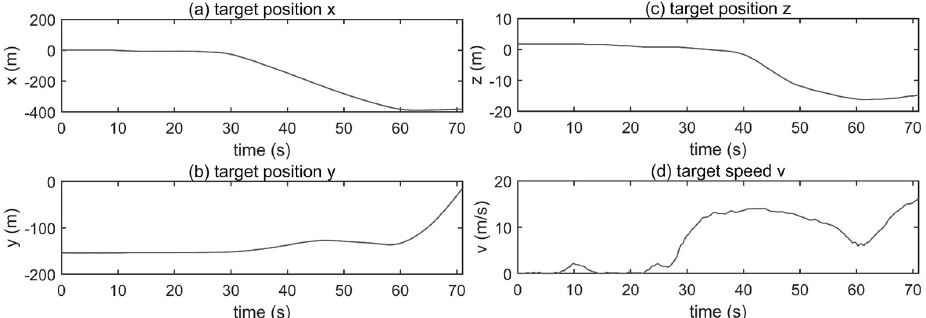
Figure 20. The information of target position and speed.